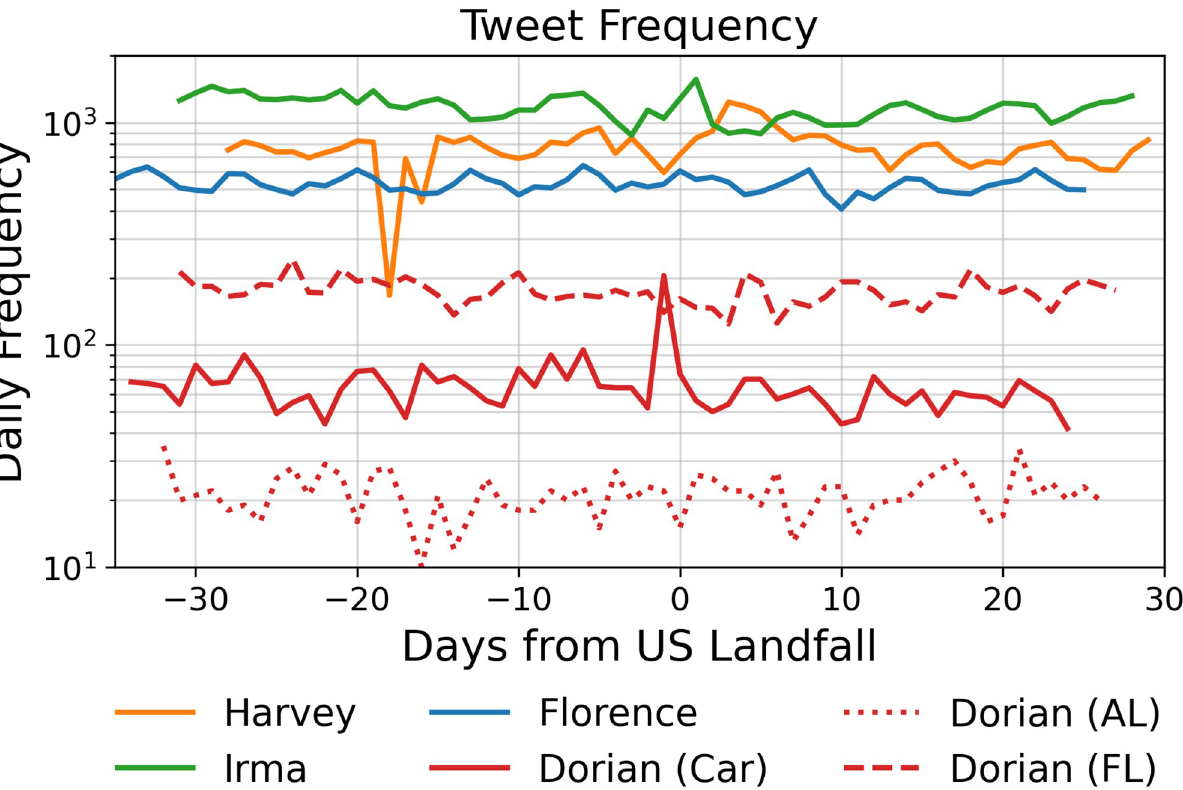
Fig 3. Daily tweet frequencies for Hurricanes Irma, Harvey, Florence, and Dorian. All dates are rescaled to the number of days since the US Landfall the area. In the case of Hurricane Dorian in Alabama, US Landfall is when President Trump predicted the hurricane would hit.